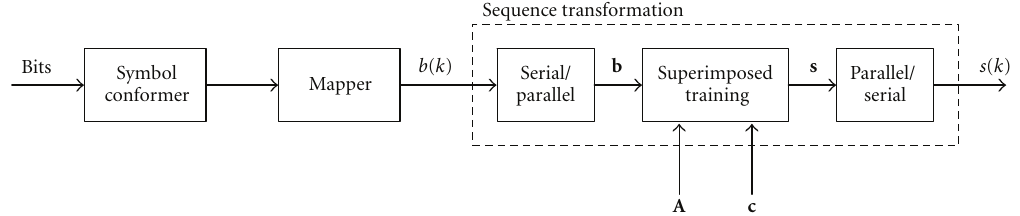
Figure 2: Block diagram of the digital baseband (data-dependent) superimposed training